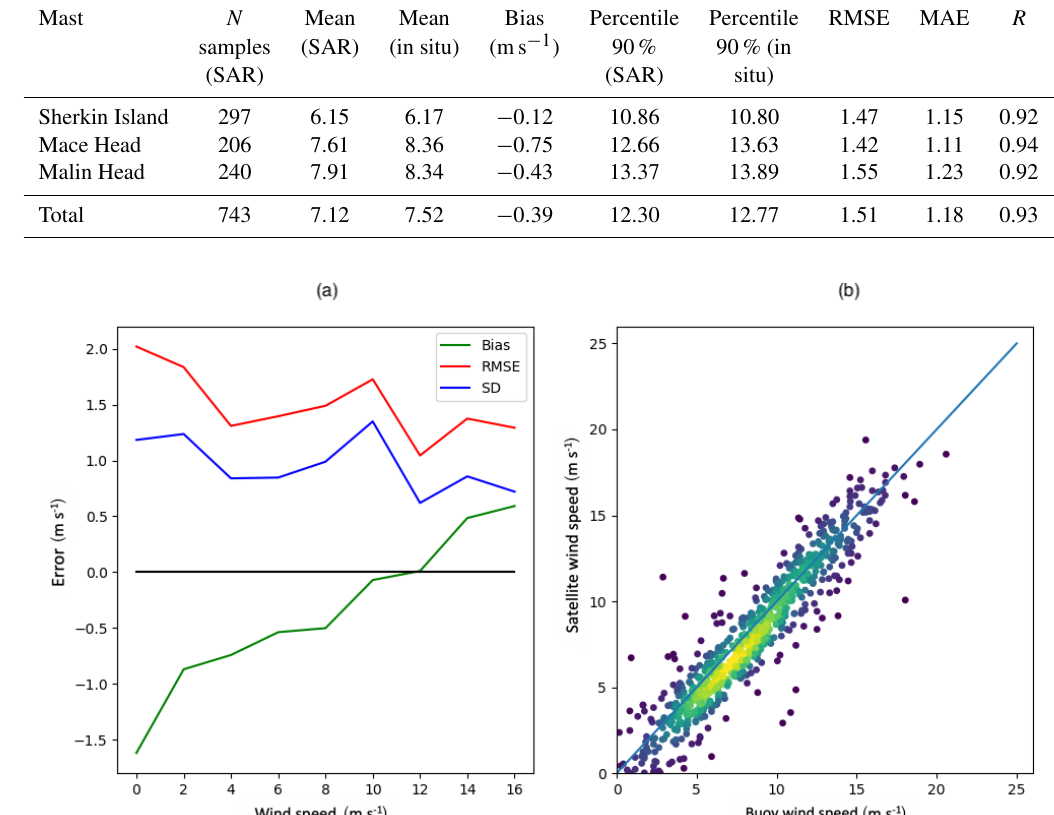
Figure 4. Statistical representation of the Sentinel-1 Level 2 OCN error against weather buoy data as a function of SAR wind speeds (a) and scatterplot versus weather buoy data (b)